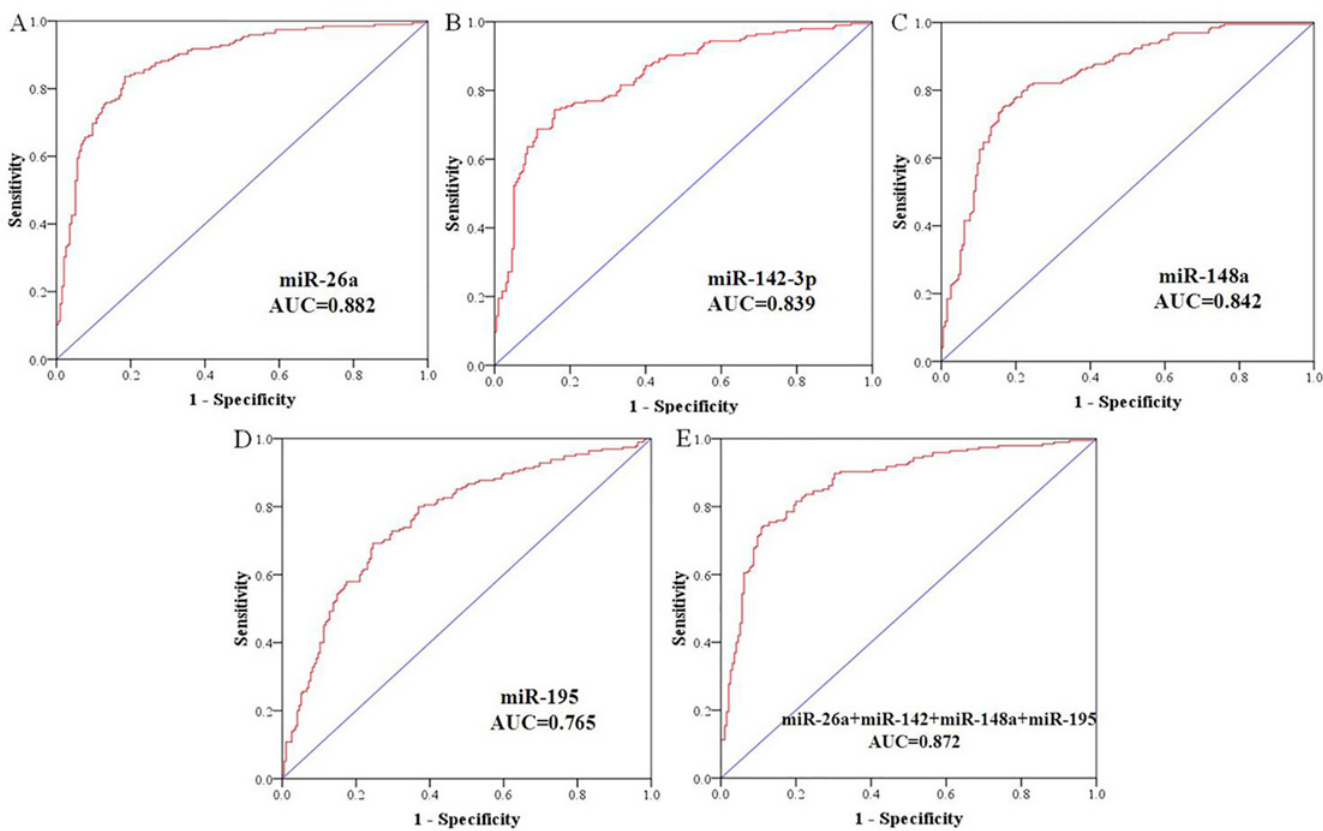
Fig 4. ROC curve analysis using four miRNAs for discriminating GC patients from healthy controls. ROC curves were constructed to show AUCs of miR-26a (A), miR-142-3p (B), miR-148a (C), miR-195 (D) and the combination of four miRNAs (E).